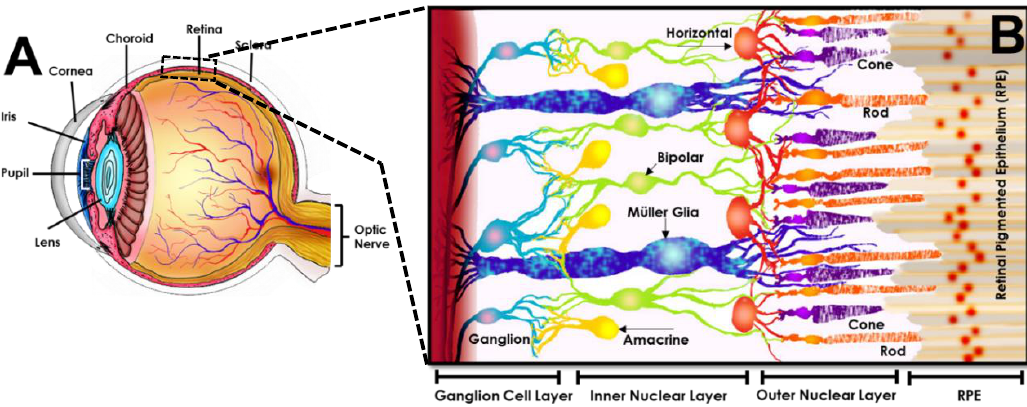
Figure 4. Representation of the human eye with retinal inset (image reproduced with permission from [143]). ( A ) Rendering of human eye illustrating (from anterior to posterior) the cornea that refracts light into the pupillary aperture controlled by the iris. Entering light is then focused through the lens and transmitted to a focal plane on the retina (dashed box), located at the eye posterior and connected to the optic nerve. The retina is adjacent to the choroid and the sclera, referred to as the “white” of the eye. ( B ) Cross-sectional, cellular schematic of the retina illustrating its three primary layers comprised of the ganglion cell layer (containing retinal ganglion cells), inner nuclear layer (hosting interneurons of amacrine, bipolar and horizontal cells), and outer nuclear layer (housing rod and cone photoreceptors). The sensory tissue, or neuro retina, is connected to the retinal pigmented epithelium (RPE), a non-sensory cell layer that interfaces with the outer blood retinal barrier at the eye posterior.